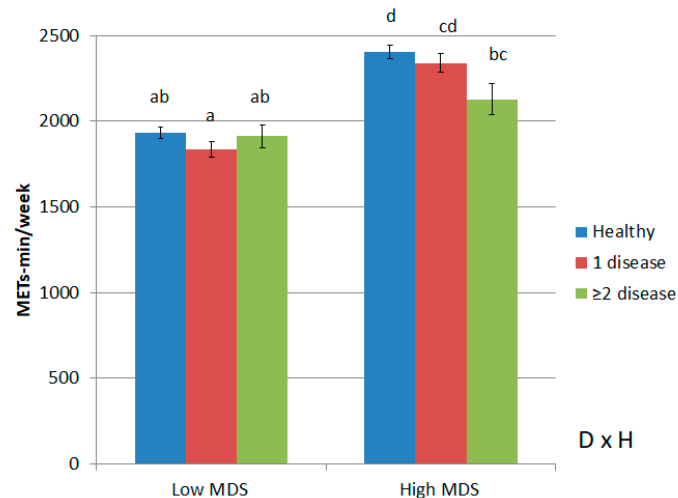
Figure 3. The interaction of healthy status or presence of metabolic diseases and dichotomized Med-